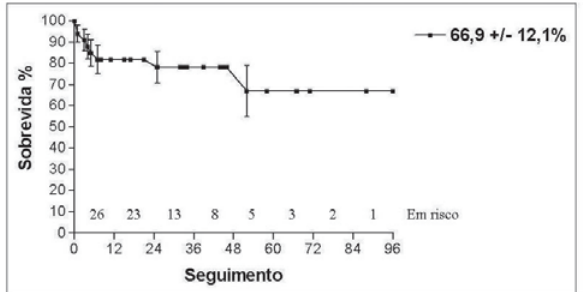
Fig. 2 - Curva de sobrevida atuarial em 8 anos